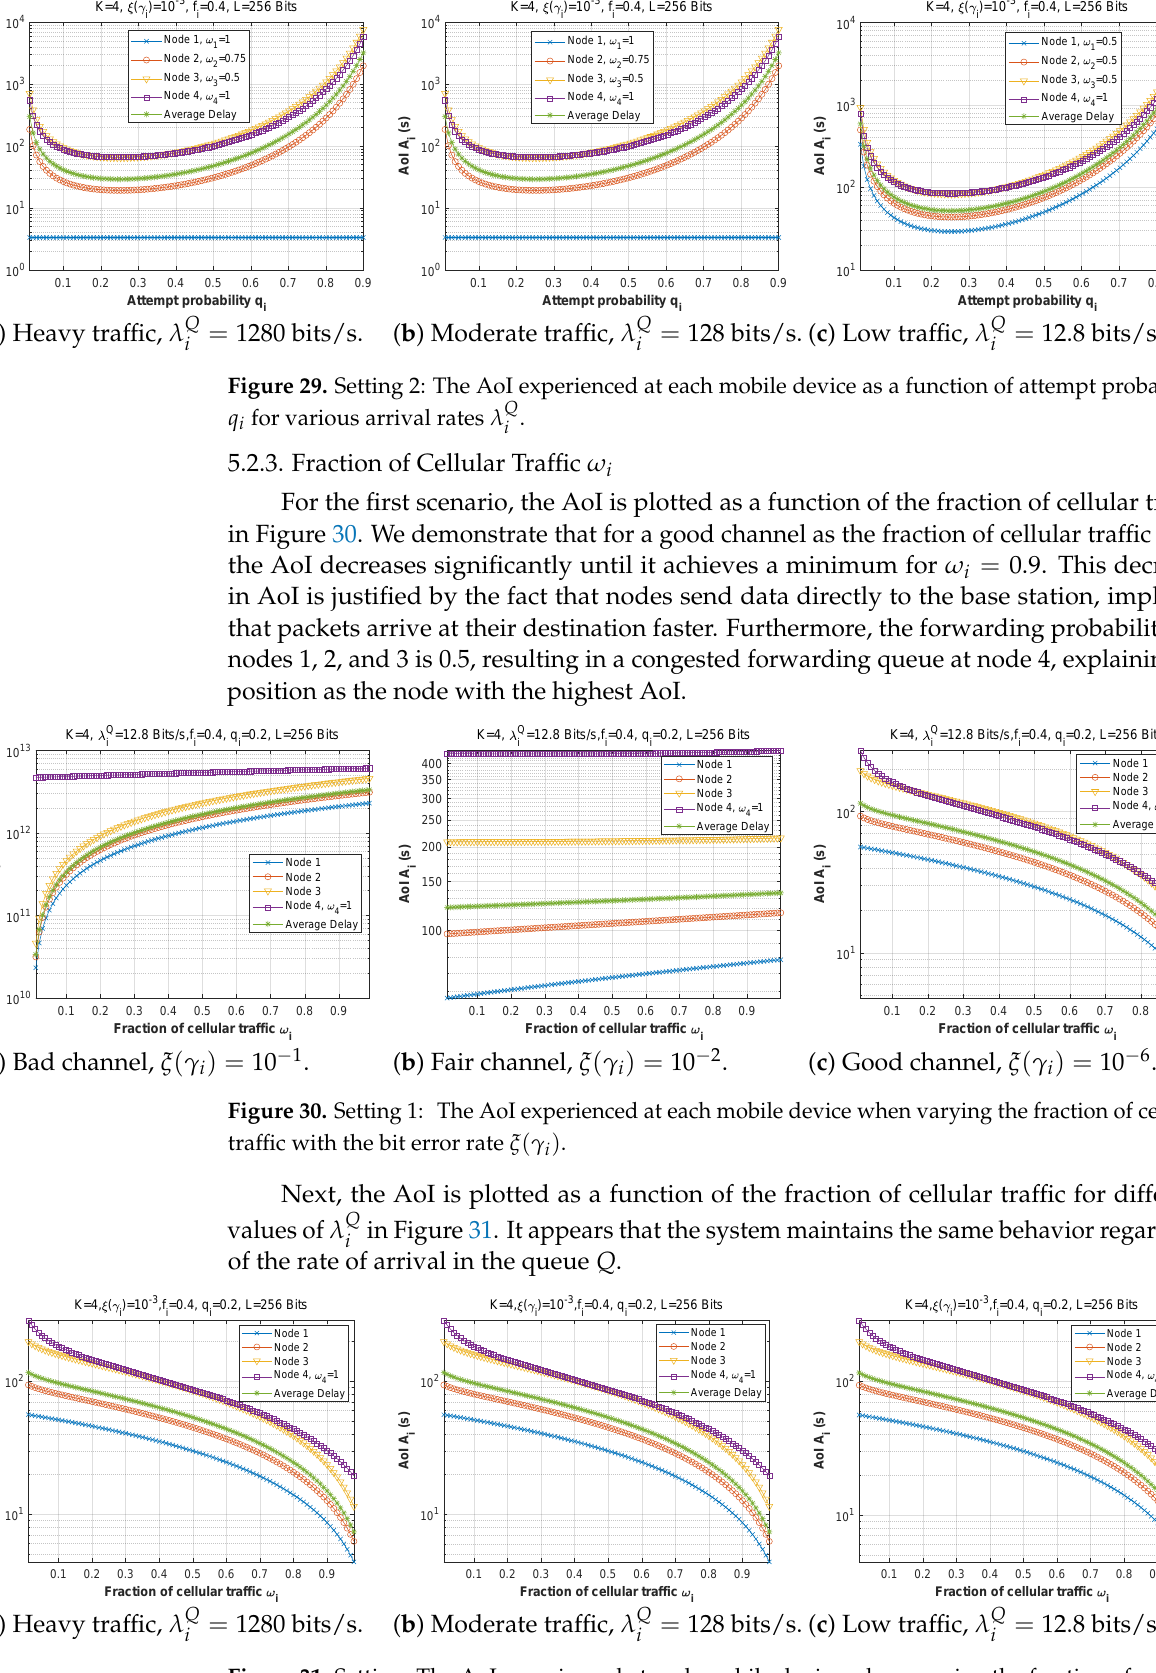
Figure 31. Setting: The AoI experienced at each mobile device when varying the fraction of cellular traffic with the arrival rate λ Q i